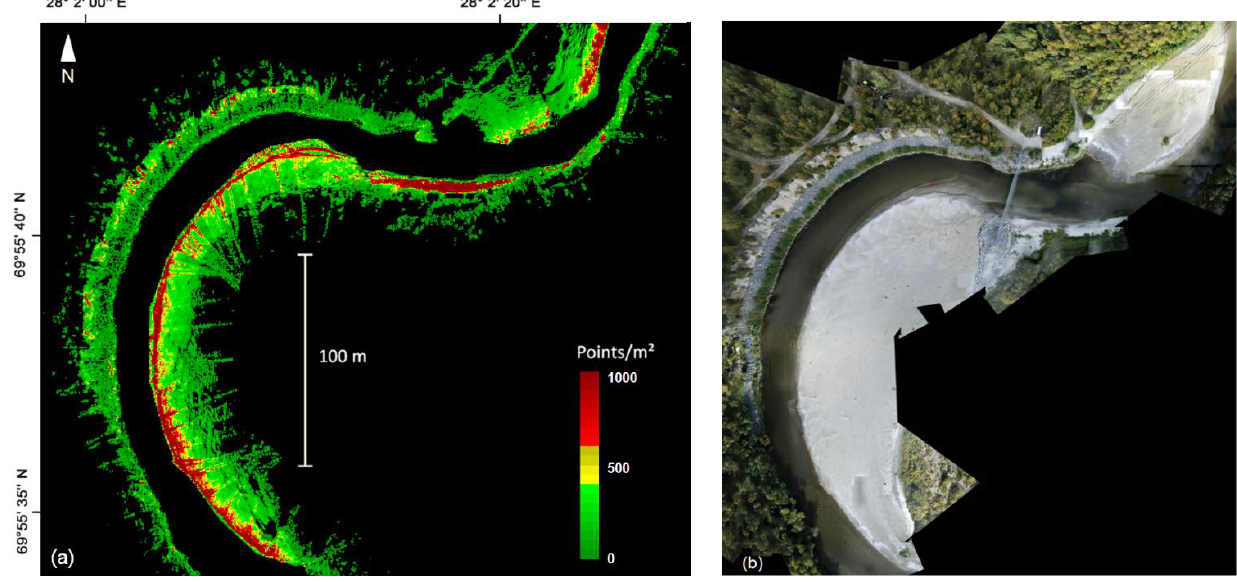
Figure 10. ( a ) The river bank and point bar point density map of classified ground points from the BoMMS data; ( b ) UAV-image mosaic of the same area.